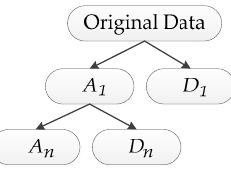
Figure 1. Universal (cid:1866) level decomposition model of WT.